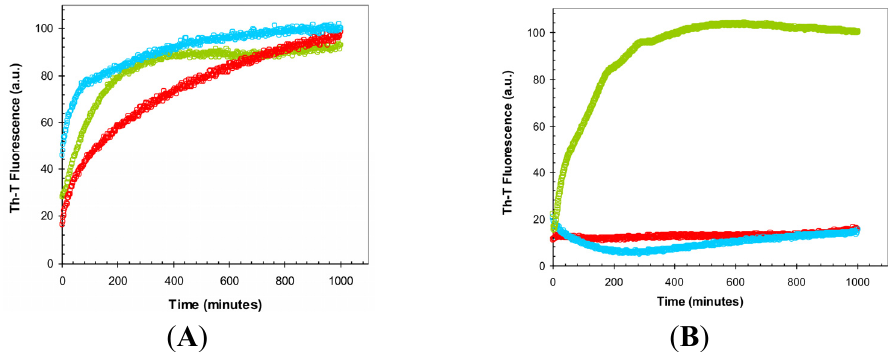
Figure 6. TFE dependence of the self-propagation of URN1-FF amyloid fibrils originating from various concentrations of TFE. Change in ThT fluorescence (25 μ M) during the aggregation of URN1-FF at 100 μ M. 10% of preformed fibrils were used for seeding and cross-seeding assays. ( A ) Aggregation reactions in the absence of TFE and ( B ) the presence of 15% TFE ( v / v ). Unseeded reactions are shown in red, reactions seeded with f0% and f15% fibrils are shown in blue and green,